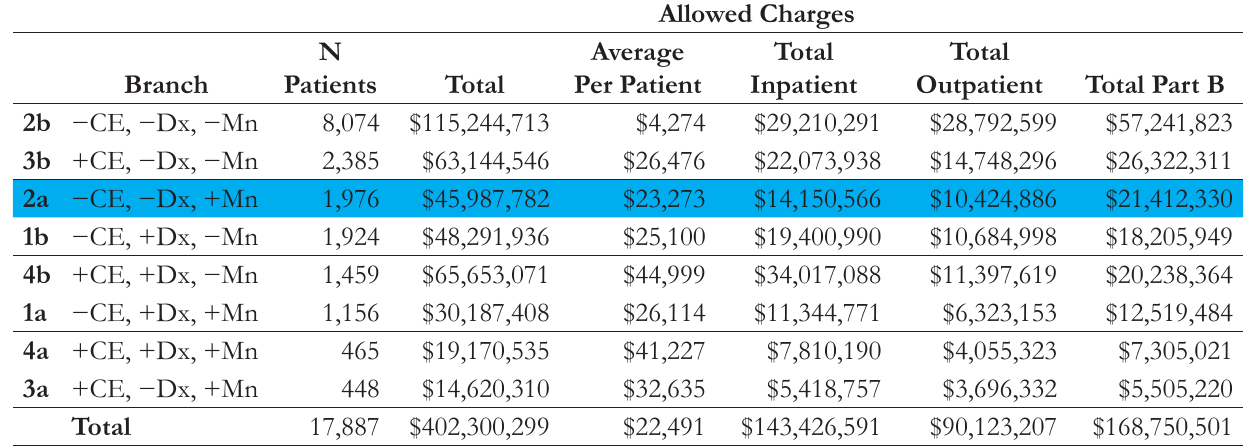
Table 2. “Diagnostic Odyssey” Patient Counts and Allowed Charges N Branch Patients Total